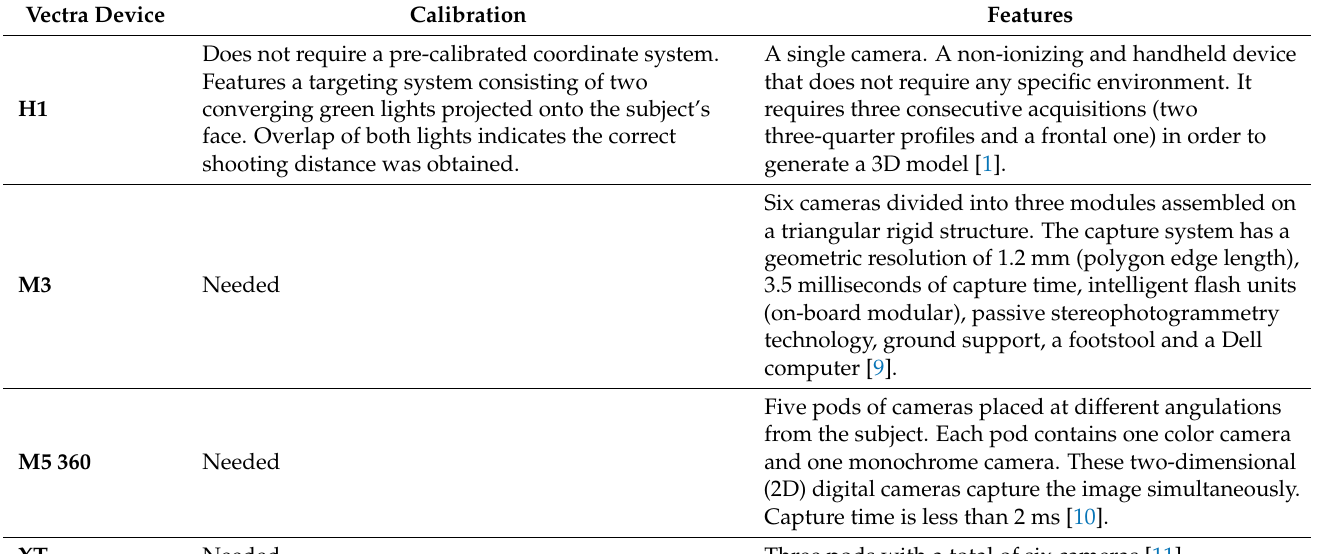
Table 1. Canfield’s Vectra